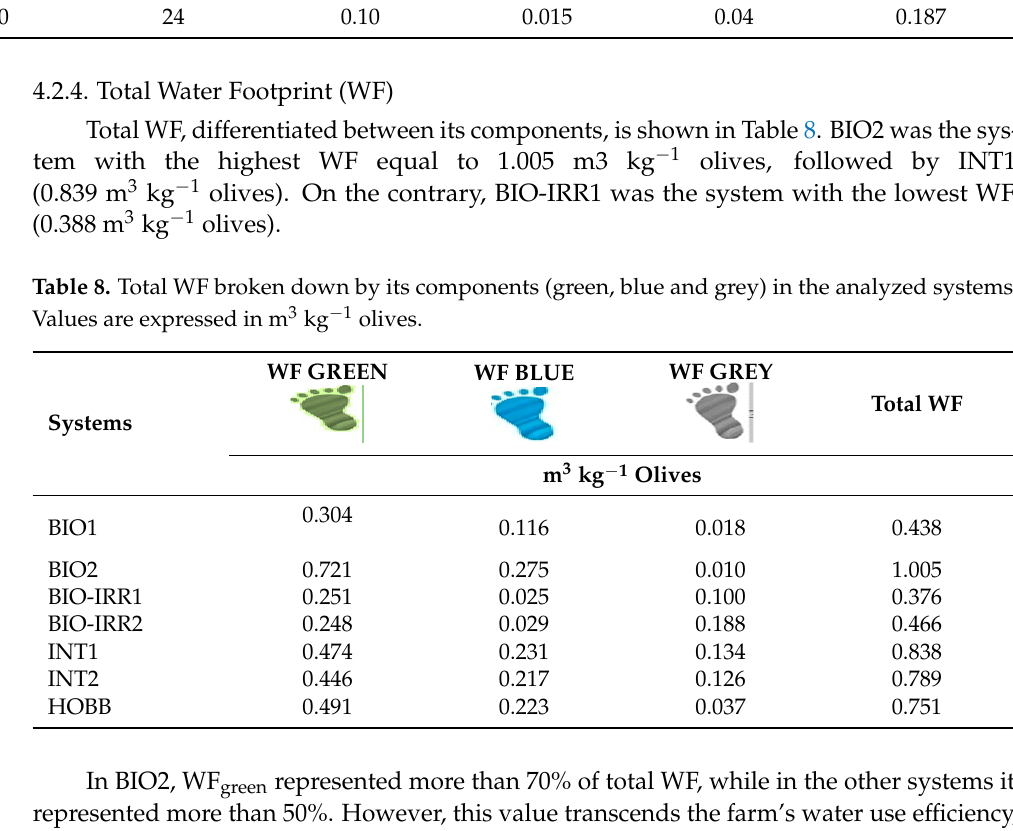
Table 7. Grey Water Footprint (WF grey ) of the analyzed systems ( α : the leaching run-off fraction; C max : the maximum acceptable concentration for the pollutant considered).